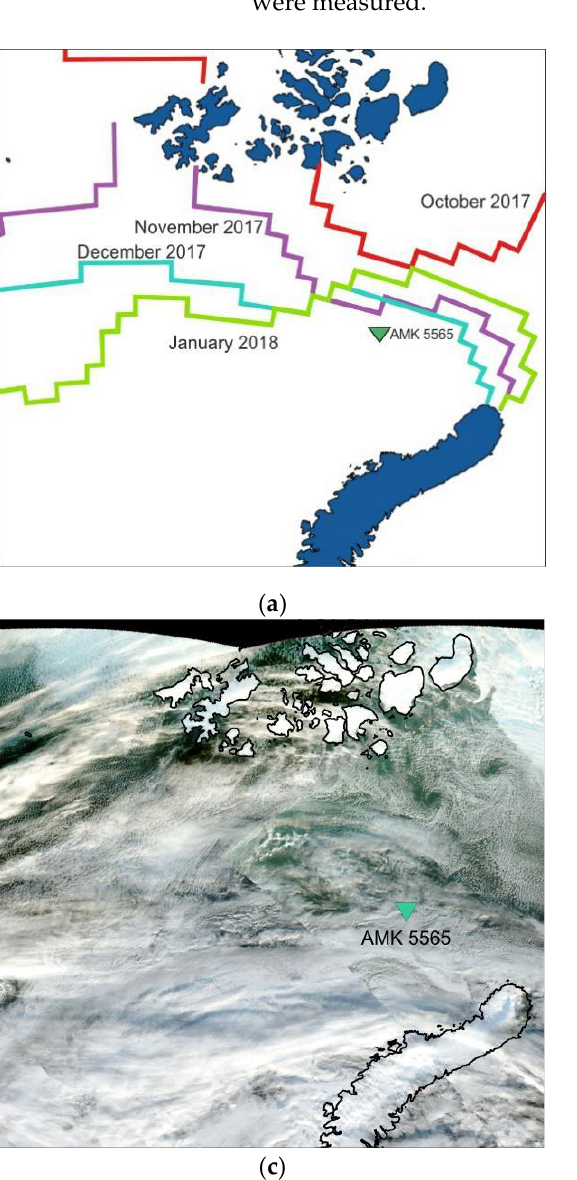
Figure 2. Sea-ice cover boundaries according to the National Ice Center Arctic and Antarctic Sea Ice data [86,87]: ( a ) in October 2017 – January 2018, when the sediment trap location was in close proximity to the sea-ice edge and ( b ) in March 2018 – June 2018, when the sediment trap location was covered with sea ice. Satellite images show ice distribution: ( c ) 6 October 2017 and ( d ) 10 April 2017 (VIIRS instrument, [88]).